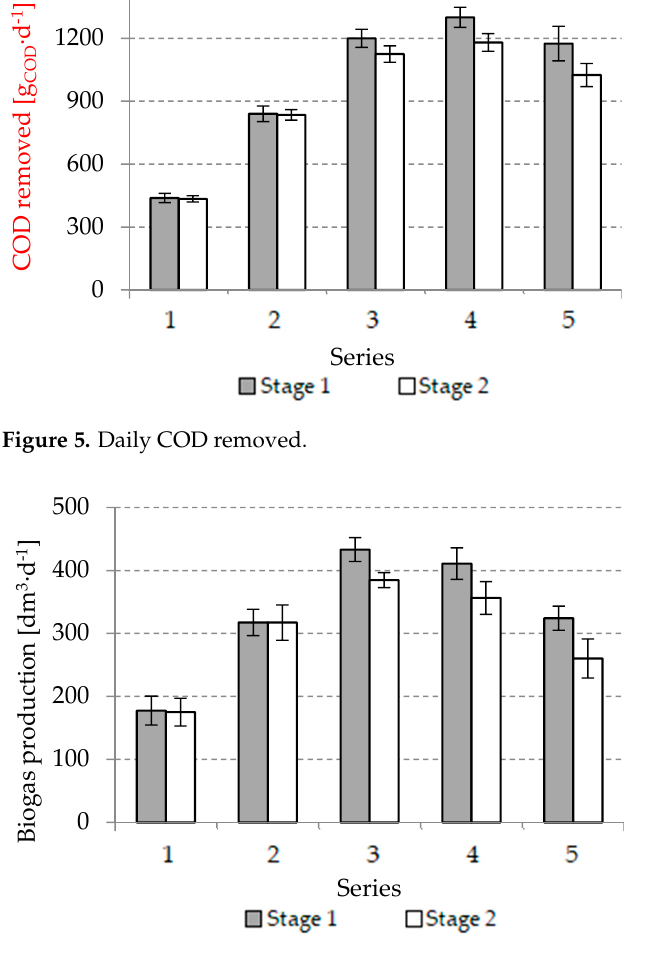
Figure 6. Daily biogas production.